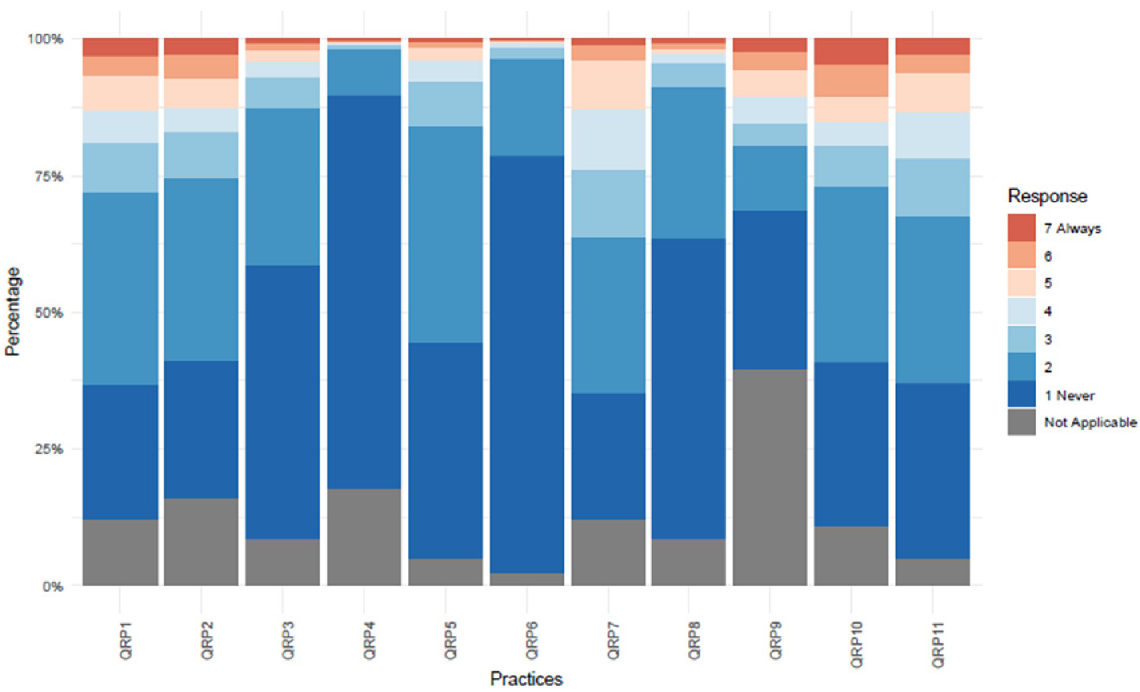
Fig 2. Percentage of observed answer categories of QRPs across 6813